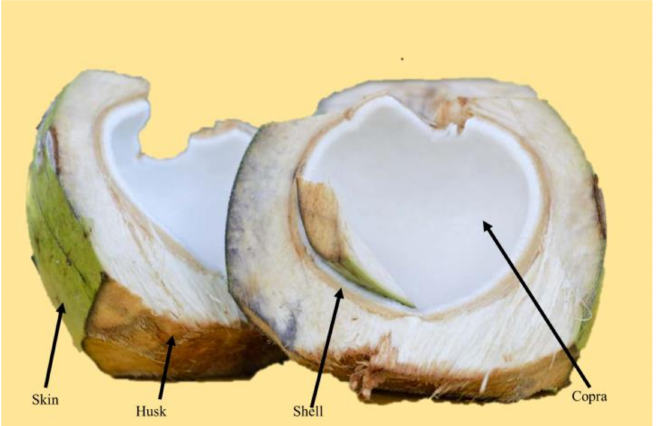
Figure 4. Cross-section of a